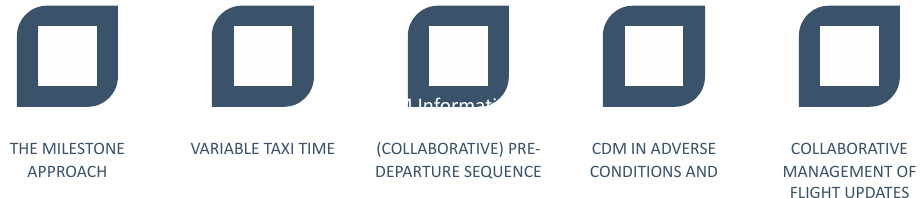
Figure 1. The airport collaborative decision making (CDM) concept elements own elaboration, Source: [1].